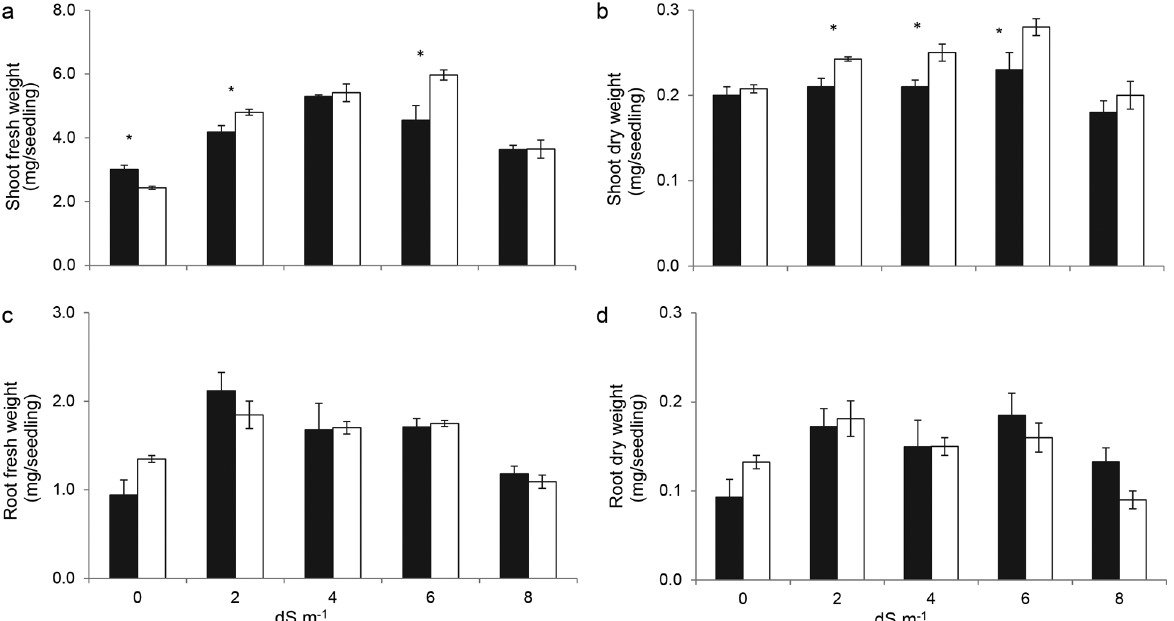
Figure 2 - Fresh and dry weights (mg/seedling) of shoots and roots of seedlings derived from non-primed (black bars) and primed seeds (white bars) of P. angulata grown under saline stress. ( a ) Shoot fresh weight; ( b ) Shoot dry weight; ( c ) Fresh root weight; ( d ) Root dry weight. Salt concentrations expressed as salt electric conductivity from zero (water) up to 8 dS m -1 . All values (mg/ seedling) are means ± SE of 4 replicates of 25 seedlings each. Asterisks represent signi fi cant differences between non-primed and primed seedlings (Student t-test at P < 0.05).